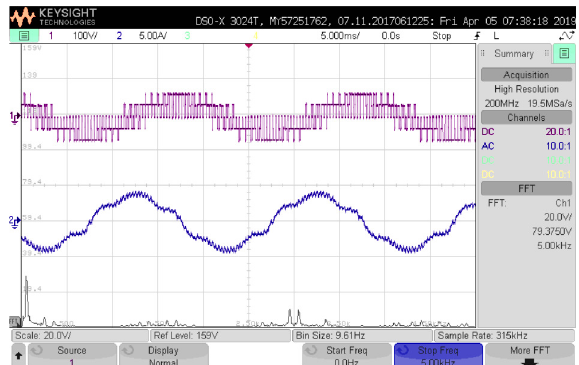
Figure 7. Voltage (upper graph) and current (middle waveform) of phase a along with the synthesised voltage spectrum (bottom) with a fundamental frequency magnitude of 0.90, while the 5th- and 7th-order harmonics are set to 0.15 and 0.10,